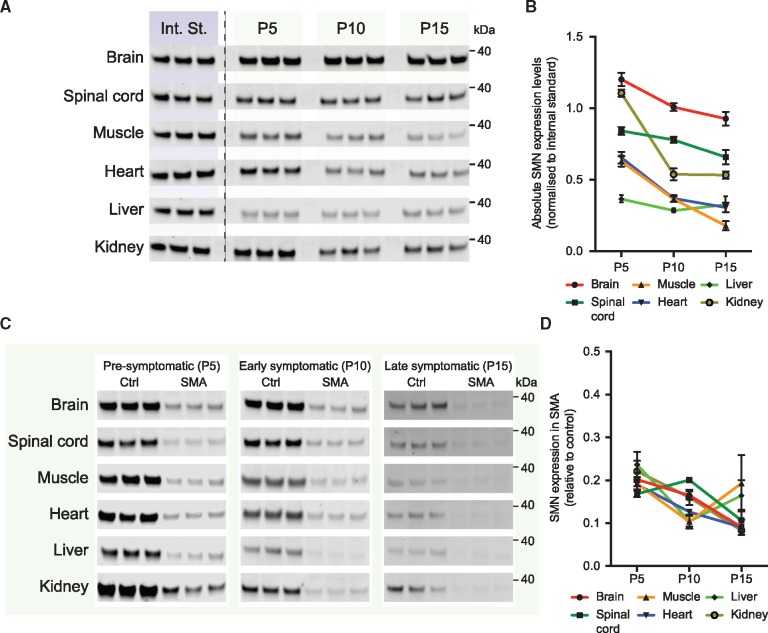

 Analysis of SMN expression in control mice and Smn2B/− SMA mice. (A) SMN expression in control littermates (Smn+/−; Smn2B/−) of the Smn2B/− model of SMA was determined using western blot in the indicated tissues. Shown are the Int. St. that was the same for all tissues and loaded in triplicate on each membrane, and SMN expression for each of the tissues at each of the indicated time points (P5, P10 and P15). (B) Quantification of SMN expression in all tissues from (A). Expression was first normalized to a fluorescent TPS and then to the Int. St., to allow direct comparison between membranes (n = 3 biological replicates for each of the tissues at each of the indicated time points, ± SEM). (C) SMN expression is shown for each of the indicated tissues at pre-, early and late-symptomatic ages (P5, P10 and P15) for both control (Smn+/−; Smn2B/−) and SMA (Smn−/−; Smn2B/−) mice. (D) Quantification of relative SMN depletion in each of the tissues at each of the time points. SMN expression in each sample was first normalized to a fluorescent TPS. SMN expression in SMA littermates is shown relative to control. kDa: 40 kDa molecular weight marker, see Supplementary Material for uncropped western blot membranes.